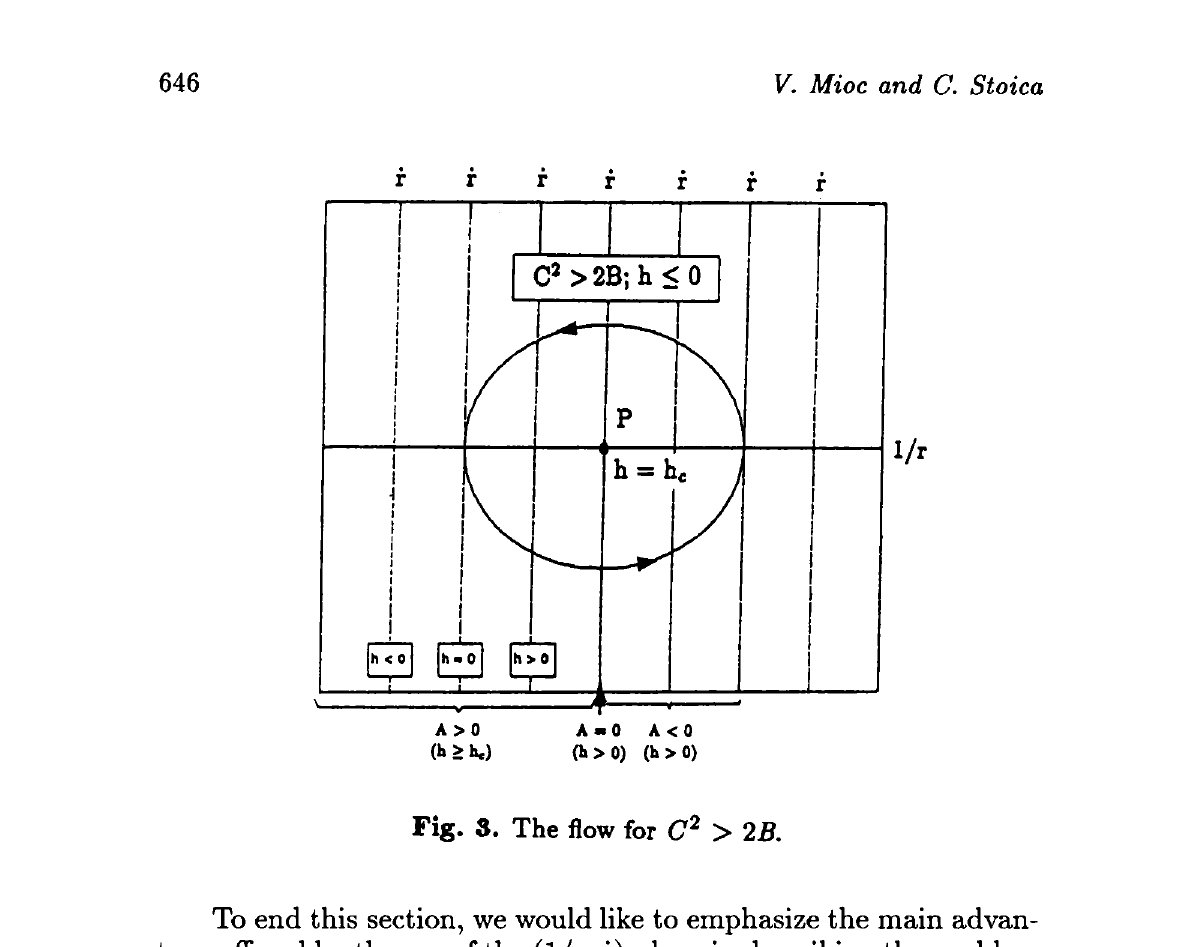
Fig. 3. The flow for C 2 > 2